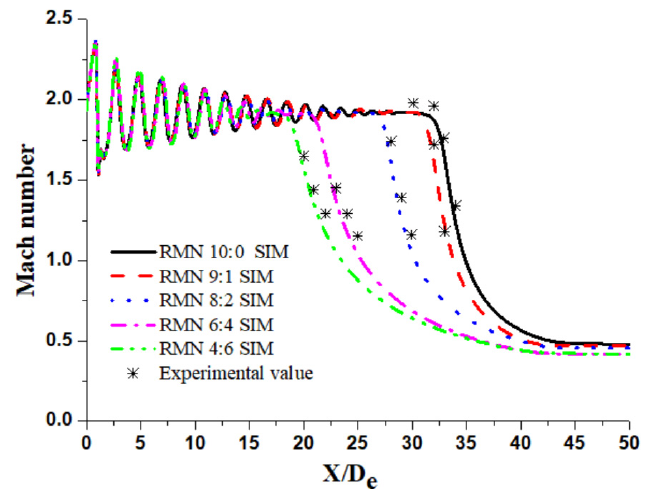
Figure 5. Axial Mach number distribution for various jets.